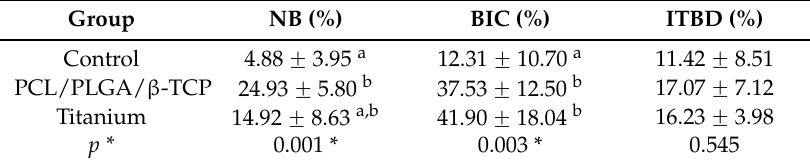
Table 1. NB (%), BIC (%), and ITBD (%) of the upper 3 threads of implants in buccal defects (means ˘ SDs; n =